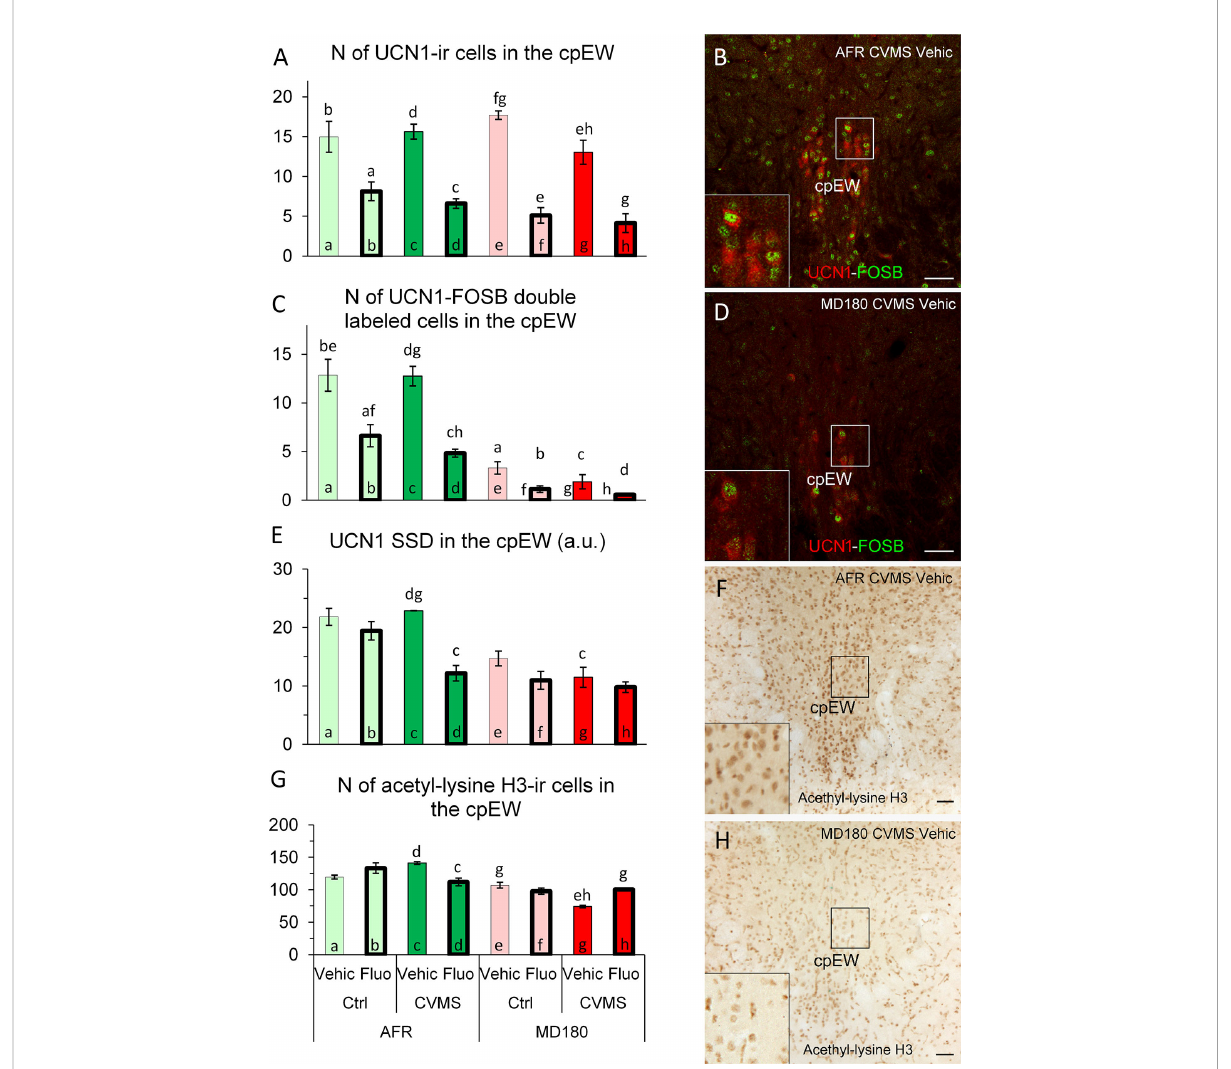
FIGURE 6 Summary of morphological results in the centrally projecting Edinger-Westphal nucleus (cpEW). (A) Number (N) of urocortin1 (UCN1)- immunoreactive (ir) cells in the cpEW. (C) N of UCN1/FOSB double labeled cells in the cpEW. (B, D) Representative microphotographs of UCN1 (green) and FOSB (red) double labeling in the cpEW of an (B) animal facility-reared (AFR), chronic variable mild stress-exposed (CVMS), physiological saline-injected (Vehic) and a (D) maternally deprived (MD180), CVMS, Vehic animal. (E) Speci fi c signal density (SSD) of UCN1 in the cpEW, expressed in arbitrary units (a. u.). (G) N of acetyl-lysine H3 histone-ir cells in the cpEW. (F, H) Representative microphotographs of acetyl-lysine H3 histone immunopositive cells in the cpEW of an (F) AFR, CVMS, Vehic mouse and an (H) MD180, CVMS, Vehic animal. Lettering at the top of bars represents the most relevant signi fi cant statistical differences between pairs of groups, according to the post hoc tests (p<0.05). Ctrl: control (i.e. not exposed to CVMS); Bar = 100